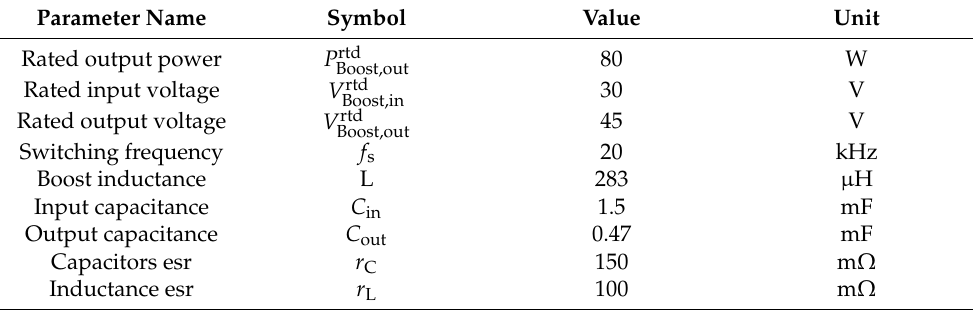
Table 1. Parameters of the investigated Boost converter.